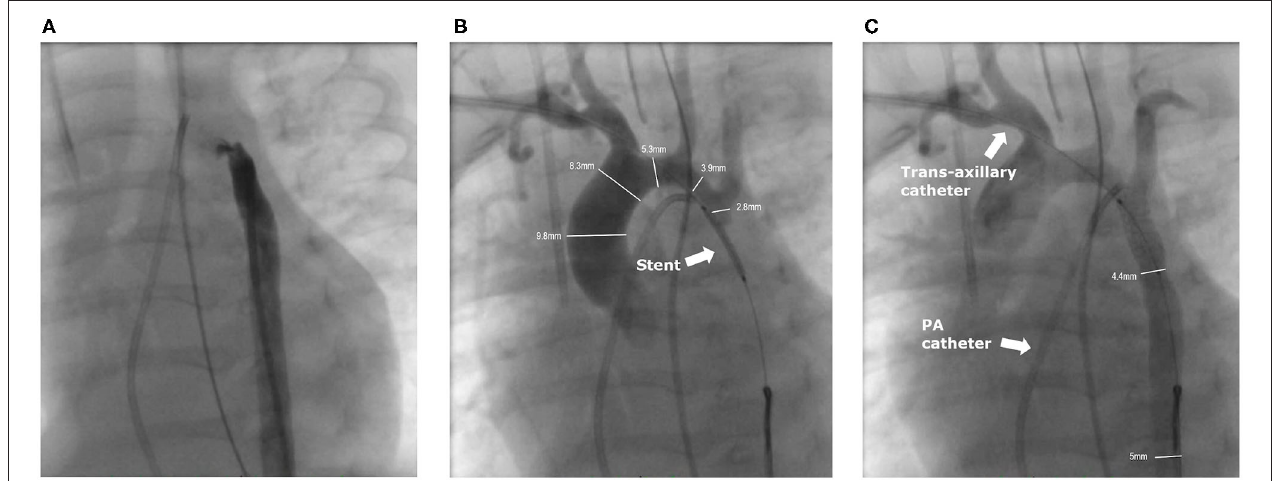
FIGURE 1 | Angiographies of the intervention. (A) Angiography from the femoral artery. The small duct is slightly contrasted, but no contrast medium crosses the stenosis of the CoA. (B) The ironman wire through the right axillary sheath is snared in the descending aorta and the pre-mounted stent is in position (arrow) after pre-dilation of the CoA with a 2.5mm coronary balloon. Contrast medium is applied through the 4F axillary sheath into the truncus brachiocephalicus. The non-inflated balloon completely obstructed the CoA. (C) Angiography after stent implantation with good position. A 4F multipurpose catheter is placed from the venous side in the small PDA (not contrasted).